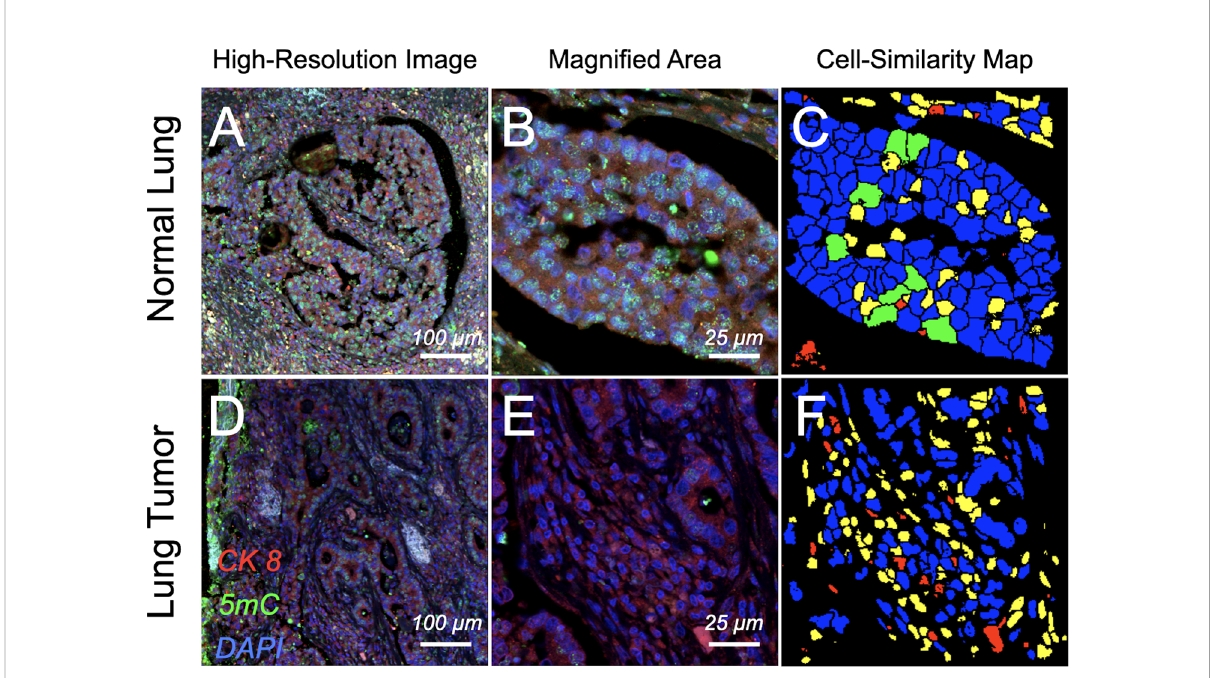
FIGURE 2 Confocal images of immuno fl uorescence-labeled lung cancer and adjacent normal tissue section. Surgically resected normal parenchyma and tumoral regions from patients that were diagnosed with lung cancer were in situ labeled for differential patterns of global DNA methylation. Cell nuclei containing global DNA marked by DAPI (false-colored blue) in normal lobules (A) and a magni fi ed subarea on the same section (B) show higher degree of DNA methylation (5mC, false-colored green) compared with severely hypomethylated nuclei in ductal regions of the tumor (D) and a respectively magni fi ed subarea (E) ; cytokeratin 8 (CK 8) (red) was used as a marker to delineate the epithelial compartments. Cell- similarity maps (C, F) illustrate higher heterogeneity in cell composition for the tumor area compared to normal tissue, illustrated by the higher number of unlikely similar (yellow) and dissimilar (red) cells. In comparison normal tissue is populated by a majority of similar (green) and likely similar (blue) cells, thus presenting a high degree of cellular